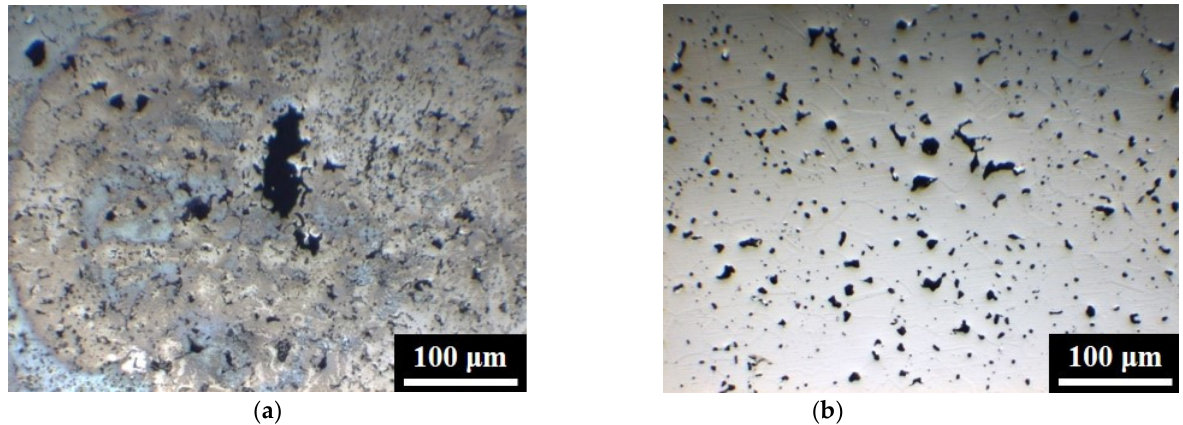
Figure 10. The surfaces of ( a ) 304L and ( b ) 304L + 0.6B after corrosion tests.